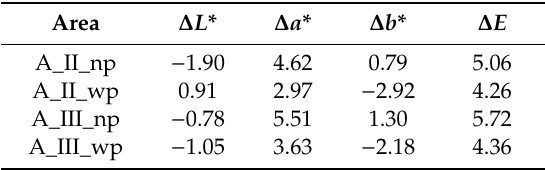
Table 3. Colorimetric measurements on unprotected and protected areas after the cleaning procedure II and